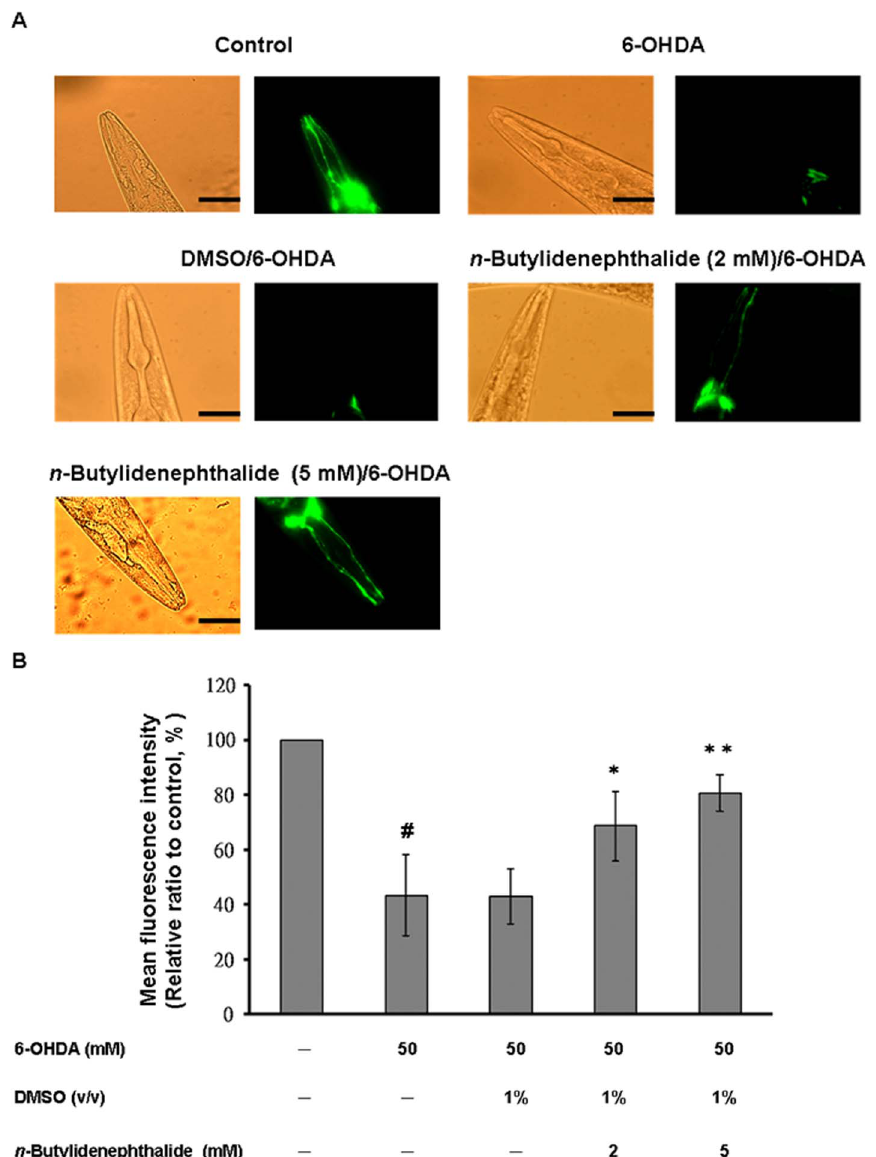
Figure 3. n -Butylidenephthalide rescues dopaminergic neurons of C.elegans from degeneration resulting from 6-OHDA treatment. (A) GFP expression pattern in dopaminergic neurons of transgenic C. elegans strain BZ555. The left side shows the differential interference contrast (DIC) image. The right side shows the fluorescence images. Scale bar, 50 m m. (B) Graphical representation for fluorescence intensity of GFP expression pattern in dopaminergic neurons of a transgenic C. elegans strain BZ555 as quantified using AxioVision software. The data represent the mean 6 SD (n=10). A hash ( # ) indicates significant differences between 6-OHDA-treated and untreated animals ( p , 0.01); an asterisk (*) indicates significant differences between the 6-OHDA-treated control samples and the n -butylidenephthalide/6-OHDA-treated samples ( * p , 0.05, ** p , 0.01). of each group. The mean survival for the n -butylidenephthalide/6- The effect of n -butylidenephthalide on the longevity of 6- OHDA-treated animals was observed. 6-OHDA-exposed animals have a shorter life span compared to wild-type N2 animals (Figure 8). The DMSO solvent had no influence on the longevity of 6-OHDA-treated animals. n -butylidenephthalide increased the life span in a dose-dependent manner. We noted that 5 mM of n - butylidenephthalide appreciably improved the life span of 6- OHDA-treated animals. Figure 8 represents the cumulative survival patterns, as calculated by Kaplan–Meier survival analysis